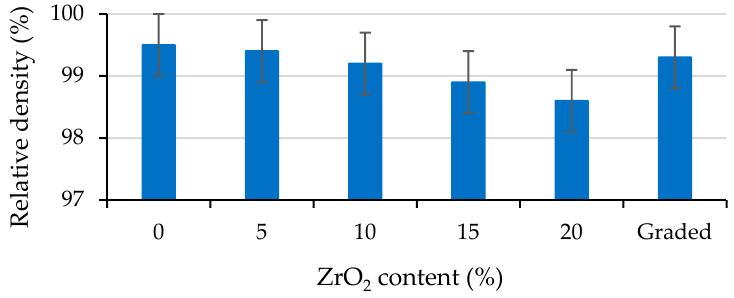
Figure 5. Relative densities of various specimens after the forging process.